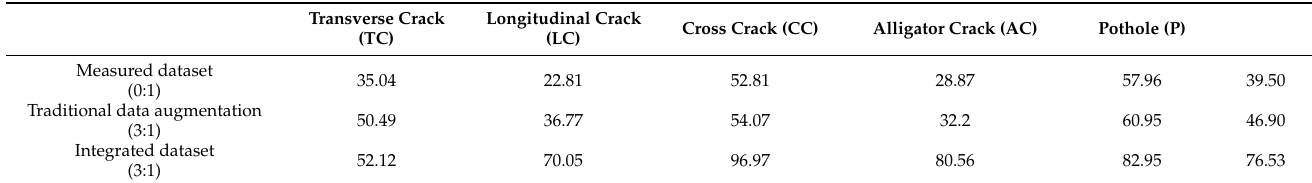
Table 4. Comparison of two data augmentation